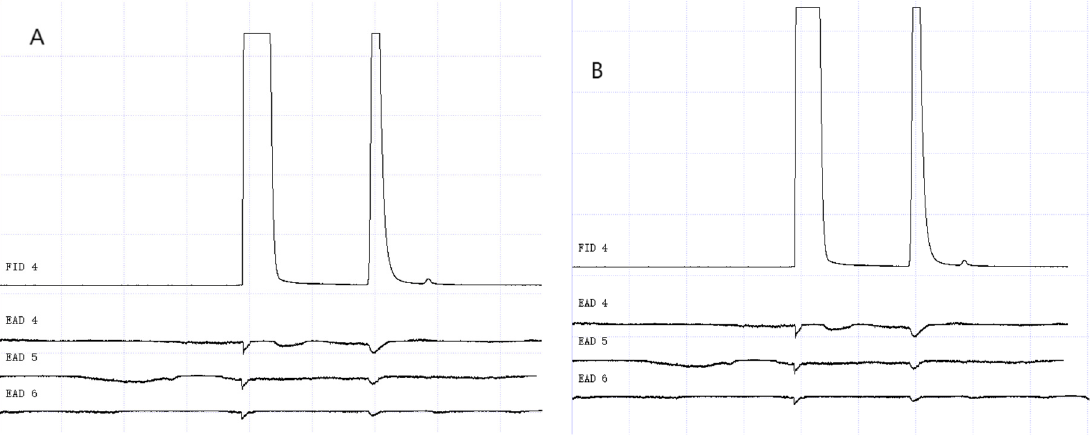
Figure 17. GC-EAD responses of 7-day-old W. magnifica to propyl butyrate. ( A ) Male. ( B ) Female.